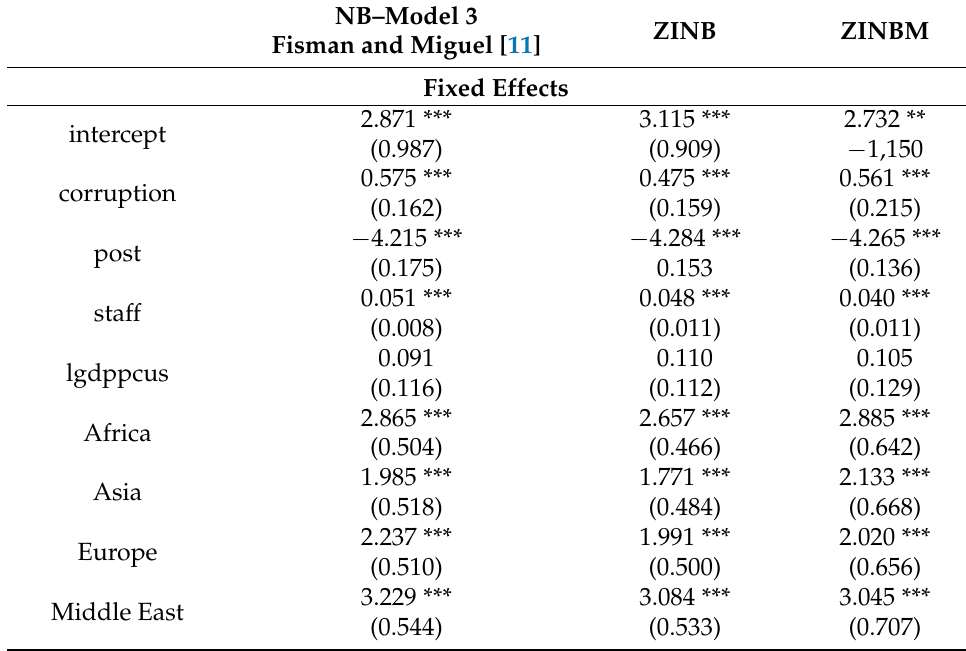
Table 6. Estimations of negative binomial model [11], and correspondent zero-inflated and zero- inflated mixed